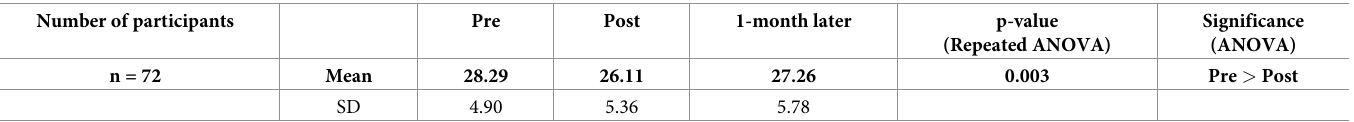
Significance (Repeated ANOVA) (ANOVA)